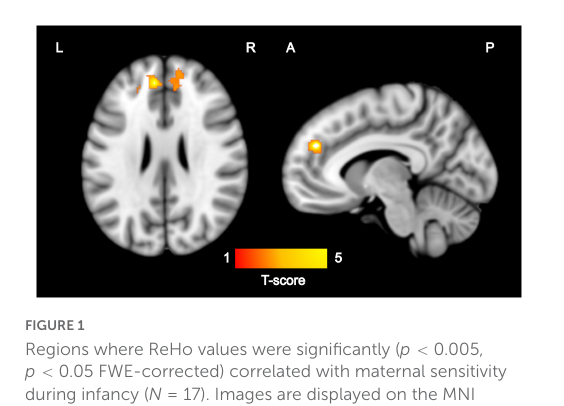
FIGURE1 Regions where ReHo values were significantly ( p < 0.005, p < 0.05 FWE-corrected) correlated with maternal sensitivity during infancy ( N = 17). Images are displayed on the MNI template in sagittal and axial slices. Color bar represents Z-scores. L, left; R, right; A, anterior; P, posterior; ReHo, regional homogeneity; FWE, family-wise error; MNI, Montreal Neurological